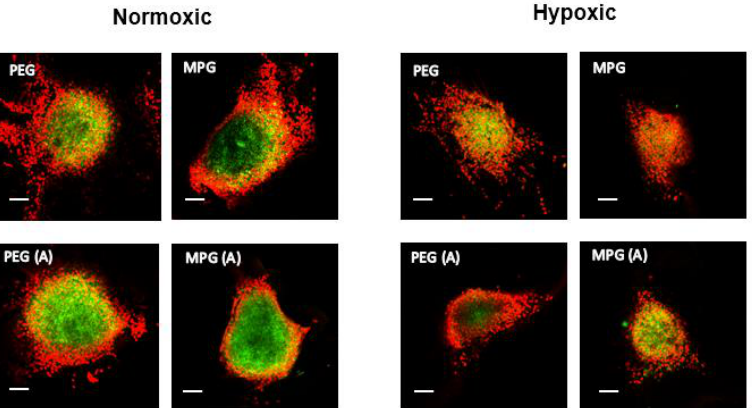
Figure 6. Representative fluorescence images of PMX spheroids including nonactivated and activated cells cultured in both normoxic and hypoxic conditions. Spheroids were incubated with 50 μg/mL NPs for 24 h after 5 days in culture. Green channel represents coumarin 6 NPs, while red represents DAPI stained cells. Scale bars represent 100 μ m.